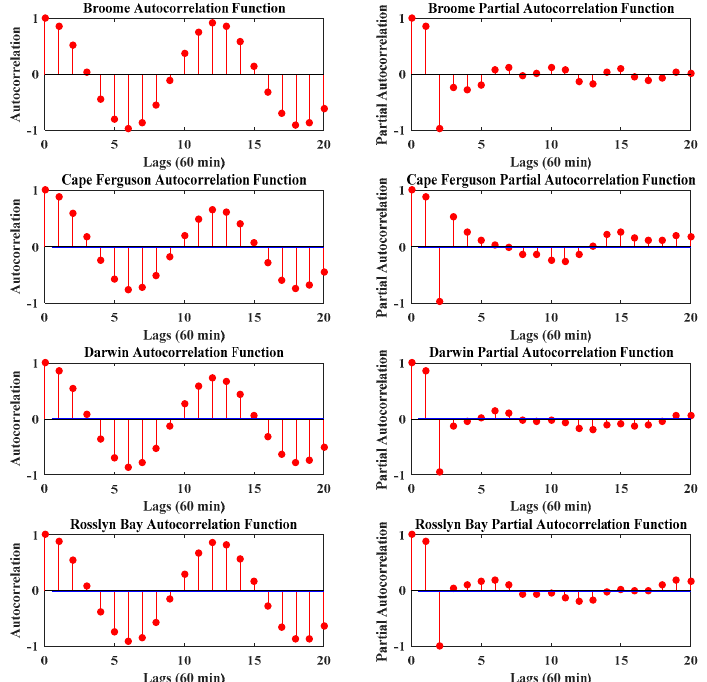
Figure 2. Autocorrelation (ACF) and partial autocorrelation (PACF) for all data locations. Considering, sea level SL as the time series variable for the 60-min interval, three significant lags of ( SL , SL t − 2 , SL t − 1 ) are then used with the other input variables of water temperature WT , air temperature AT , barometric pressure BP , residuals R , adjusted residuals AR , wind direction WD , wind gust WG , and wind speed WS . Table 2 shows the cross-correlation results of the inputs and target variable SL for the Broome dataset. Table 2. Cross-correlation results of the inputs and target variable sea level for Broome tide gauge station.